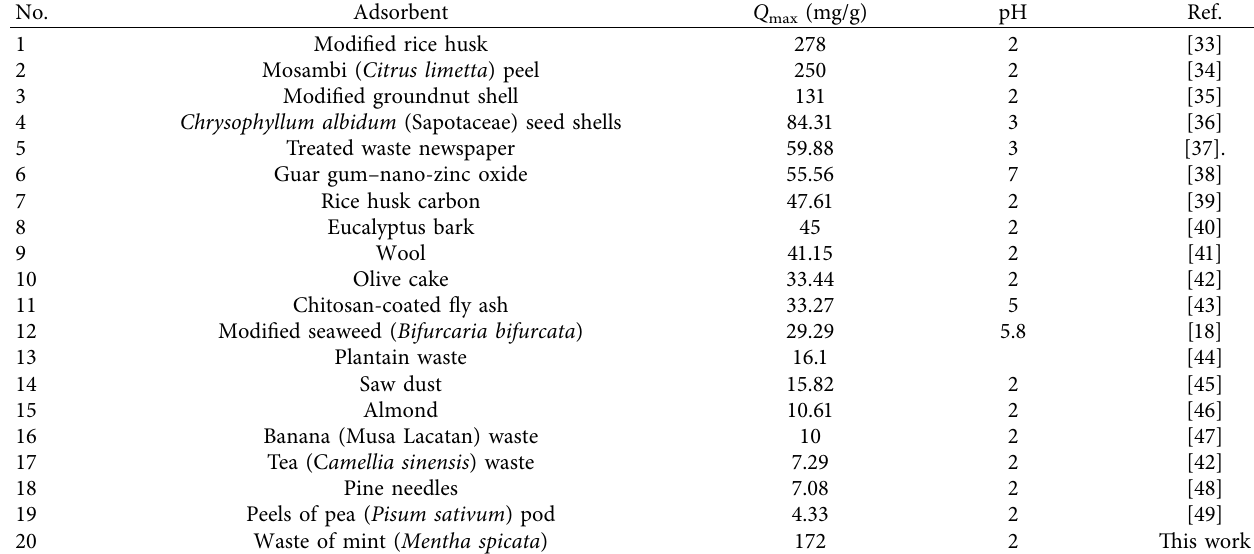
Table 5: Comparison of adsorption capacities of WM with other adsorbents for Cr(VI).